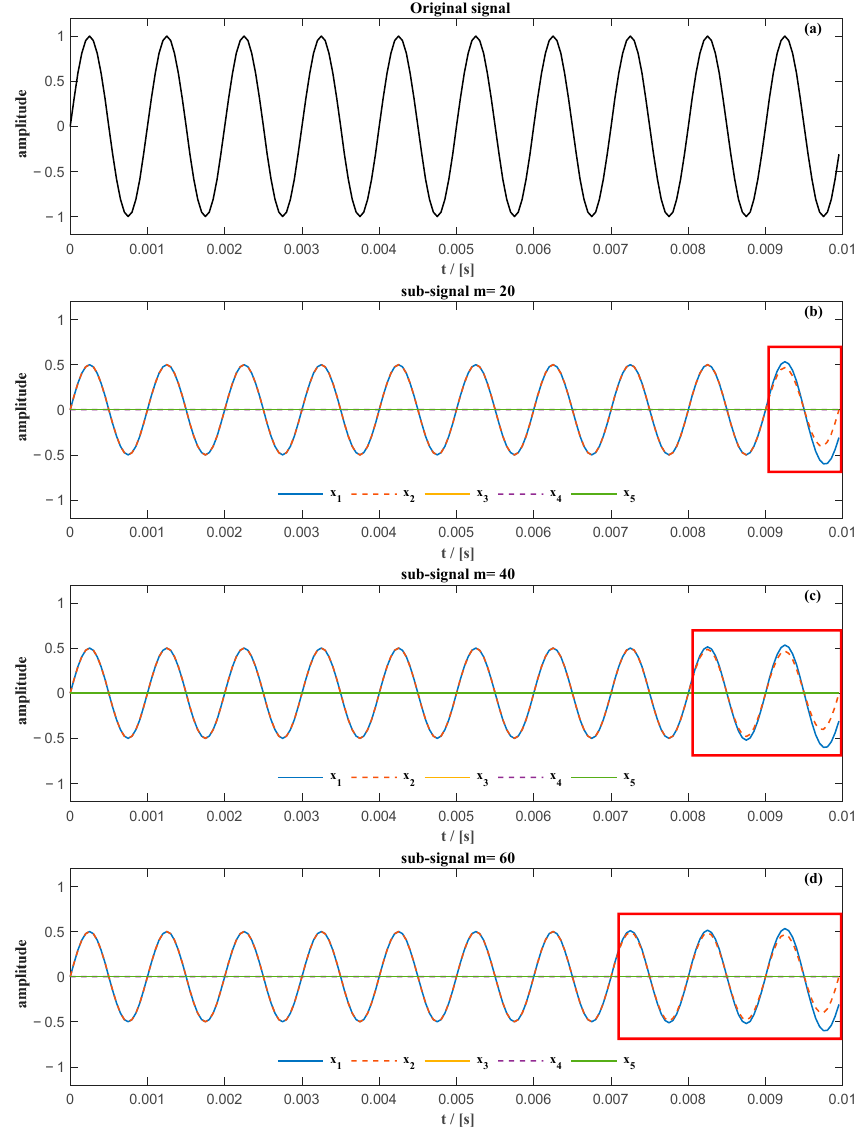
Figure 1. The sinusoidal signal and the first five sub-signals decomposed using the different number of rows m .